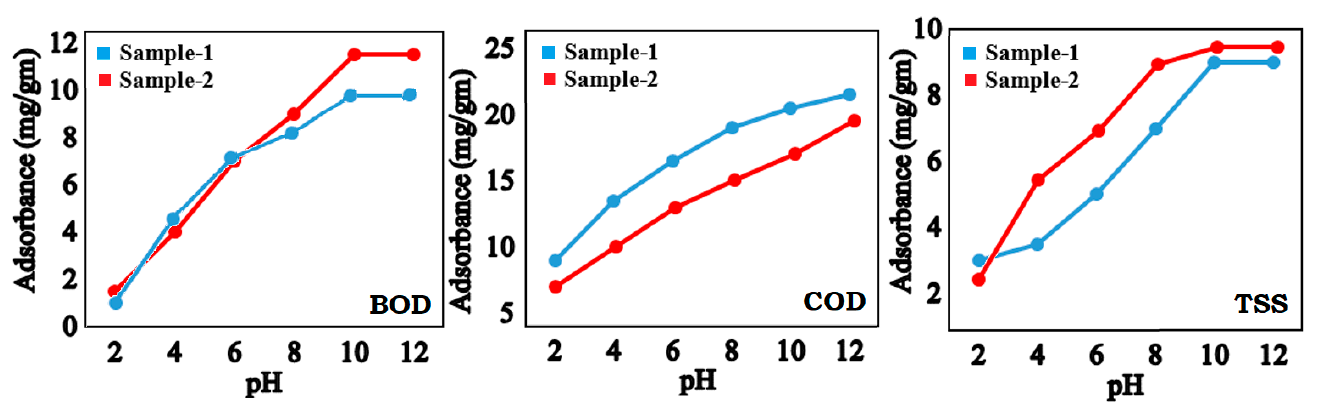
Figure 5. Adsorption concentrations (mg/gm) of BOD, COD and TSS in sample 1 and 2 at different pH.